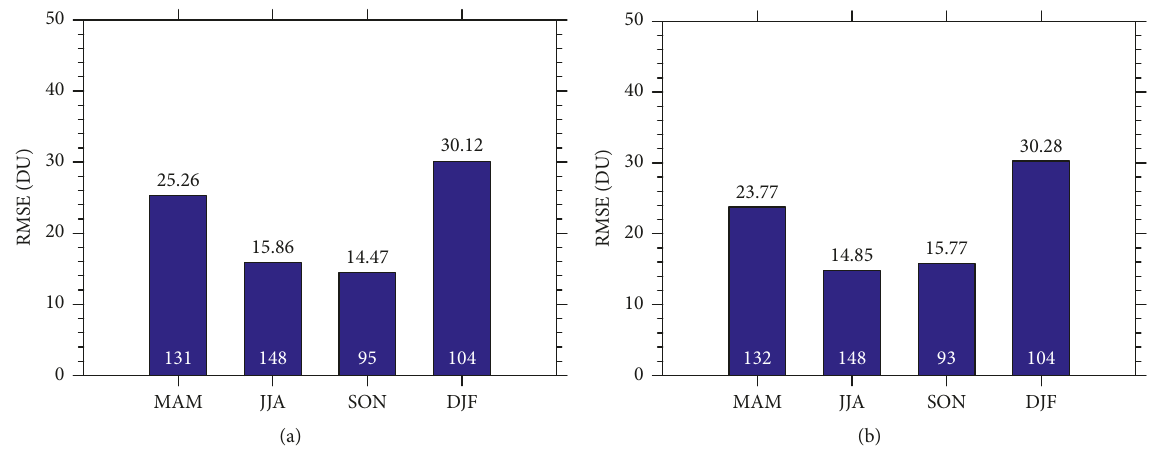
Figure 10: Seasonal characteristics of total ozone RMSE between the observed and forecasted value ( D +1) in (a) Seoul and (b) Pohang.